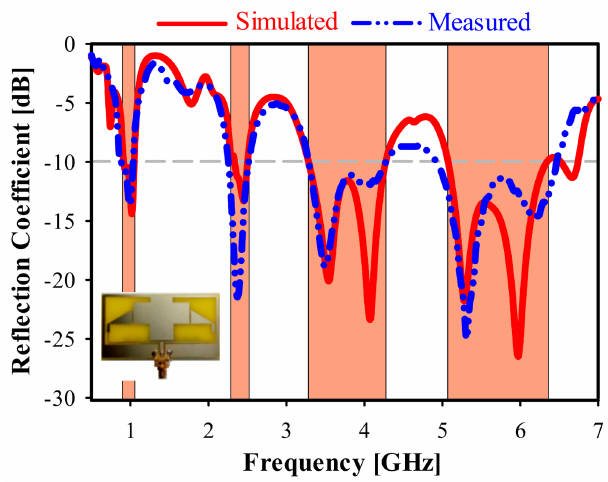
Figure 13. Simulated and measured reflection coe ffi cient (S11) with MTM.